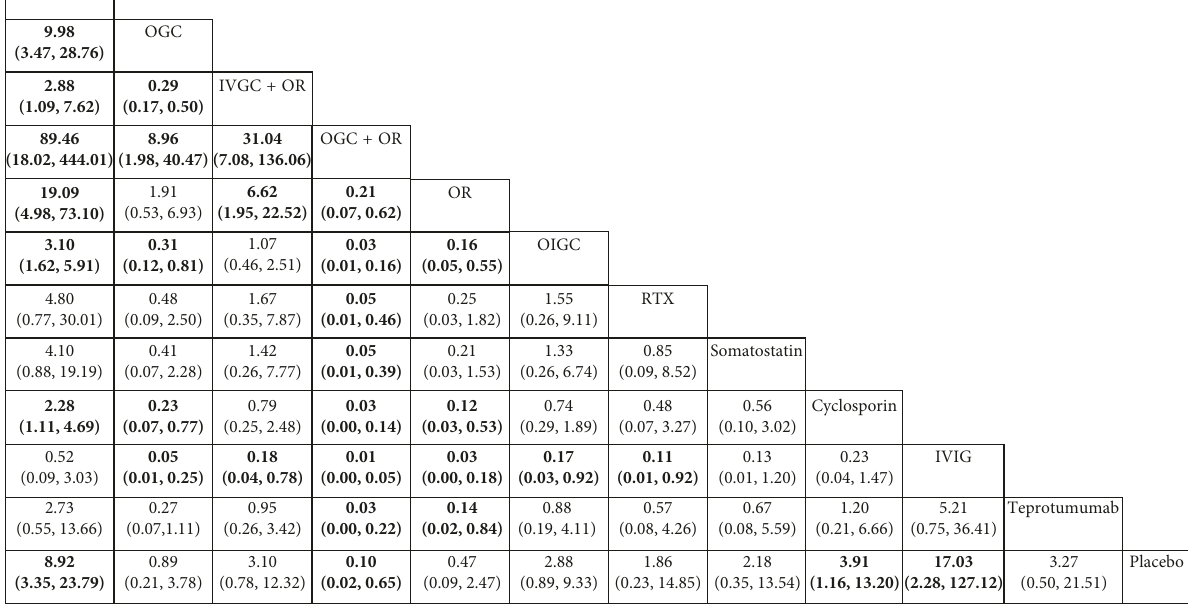
Figure 4: The confidence intervals of estimates for the network analysis. The bold and underlined data indicate that there are statistically significant effects. ( P < 0 . 05).